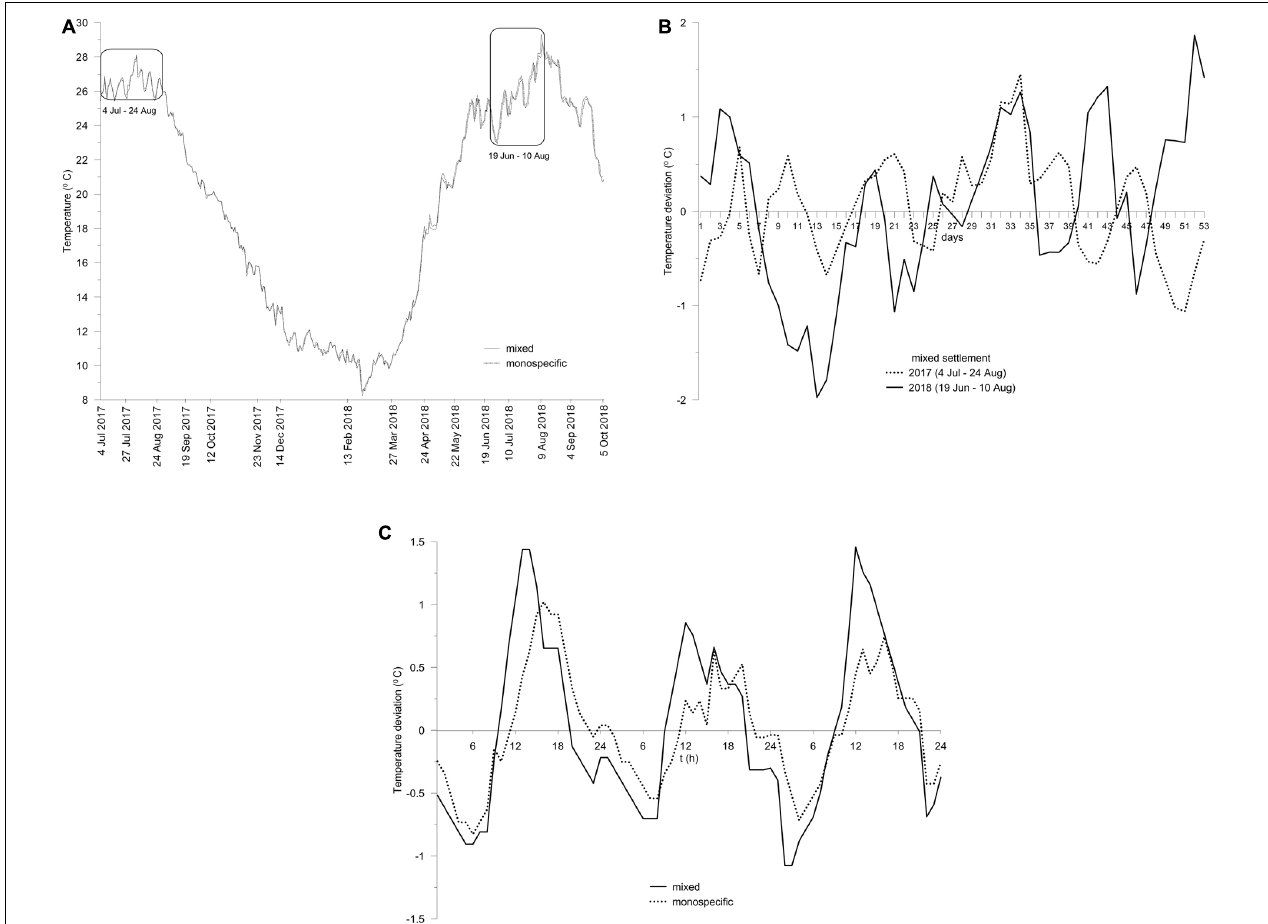
FIGURE 2 | Daily seawater temperature in mixed and monospecific settlements from 4 July 2017 to 5 October 2018. Marked areas represent the periods when the daily temperature oscillations were calculated (A) . The oscillations in daily temperatures relative to the monthly average in the mixed settlement encompassing the periods up to the samplings in July and August of 2017 and 2018, relevant to explain the difference in the physiological state of C. cylindracea between summers of 2017 and 2018 (B) . Temperature oscillation pattern in August 2018 in the mixed and monospecific settlement, relevant to explain the difference between the relative sizes of C. cylindracea population that underwent spawning in two settlements (C)